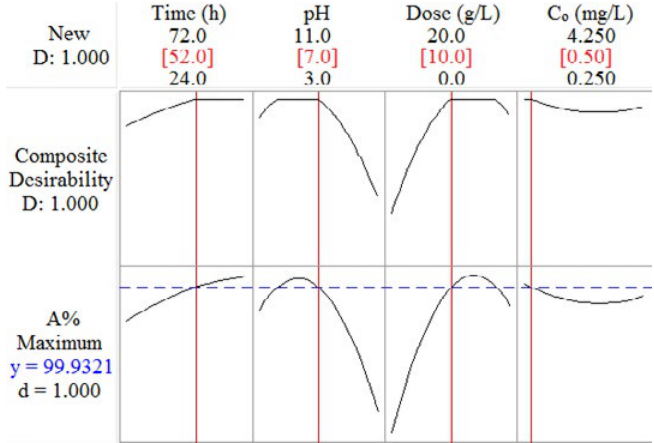
Fig. 9: Response optimization plot for the adsorbate adsorption efficiency